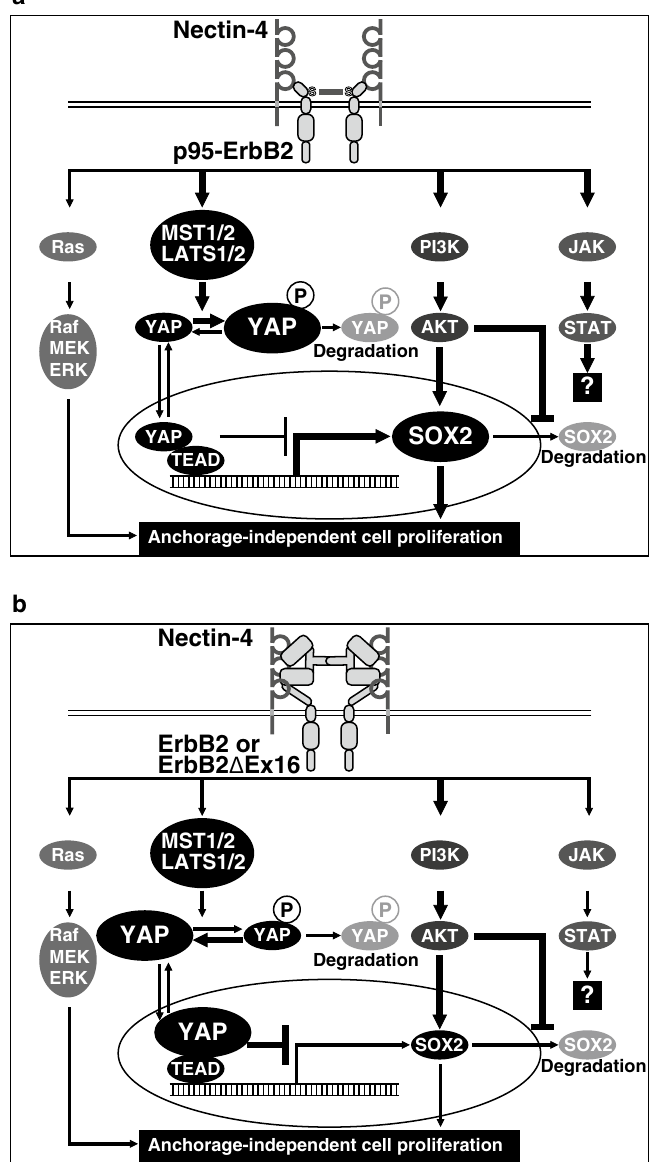
Figure 7. Proposed mechanisms for the enhancement of T47D cell proliferation by nectin-4 and p95-ErbB2 through the Hippo signaling-dependent SOX2 gene expression in a suspension culture. ( a ) A mechanism for nectin-4 and p95-ErbB2. Nectin-4 and p95-ErbB2 cooperatively activate not only the PI3K-AKT signaling but also the MST1/2-LATS1/2 signaling. The PI3K-AKT signaling increases the amount of the SOX2 protein by enhancing its gene expression and inhibiting its proteolytic degradation. The MST1/2-LATS1/2 signaling phosphorylates YAP, keeping the phosphorylated YAP in the cytoplasm, eventually suppressing its inhibitory role in the SOX2 gene expression induced by the PI3K-AKT signaling. As a result, nectin-4 and p95-ErbB2 cooperatively increase the amount of the SOX2 protein, enhancing T47D cell proliferation in a suspension culture. ( b ) A mechanism for nectin-4 and either ErbB2 or ErbB2∆Ex16. Nectin-4 and either ErbB2 or ErbB2∆Ex16 activate the PI3K-AKT signaling, but not the MST1/2-LATS1/2 signaling. YAP is translocated into the nucleus and inhibits the SOX2 gene expression. As a result, nectin-4 and either ErbB2 or ErbB2∆Ex16 do not increase the amount of the SOX2